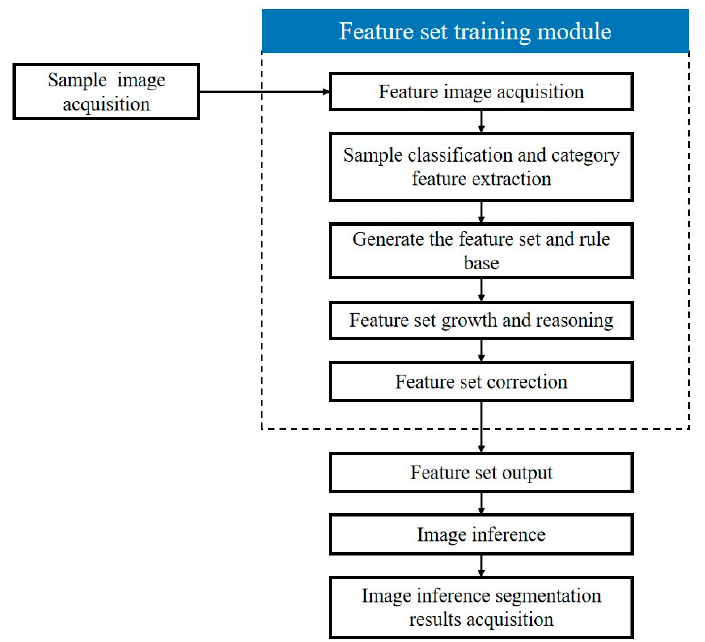
Figure 1. Flowchart of the proposed method.